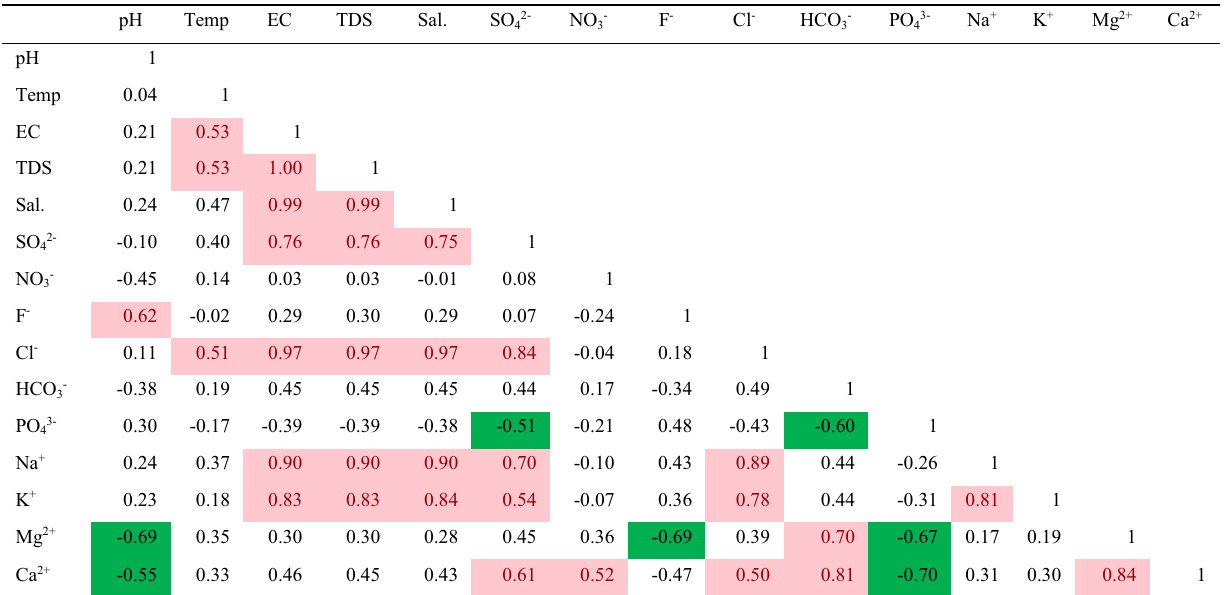
Table 2 Pearson correlation matrix for samples from well water